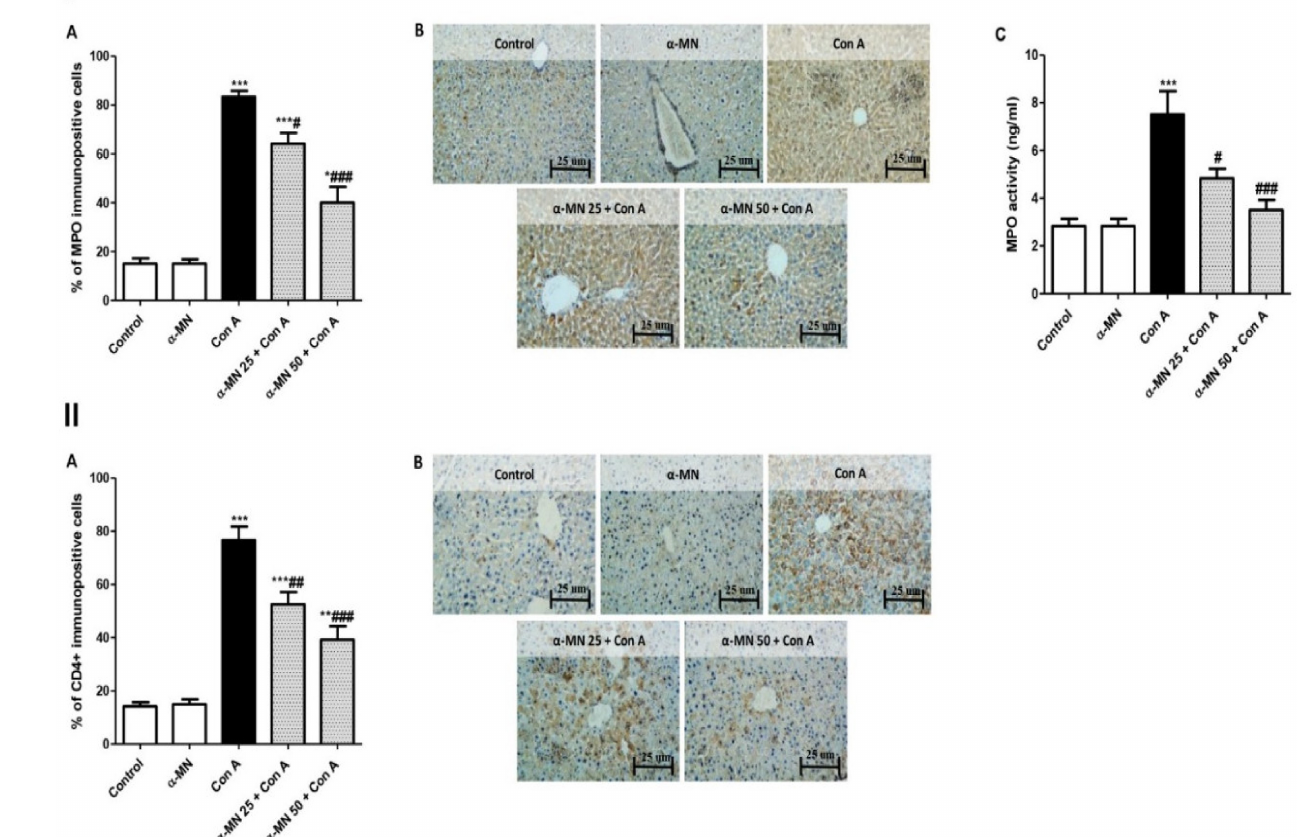
Figure 4. Alpha-mangostin ( α -MN) decreased concanavalin A (Con A)-induced infiltration of the neutrophiles and the CD4+ T cells into the liver. ( I ) MPO immuno-expression and level; ( II ) Immuno- expression of CD4+ in the hepatic specimen. The immuno-staining of MPO and CD4+ of the control and α -MN groups was minimal while that of Con A was high; α -MN pre-treated groups showed a remarkable lowered level of immunostaining for both MPO and CD4+ ( × 200). Data are the mean ± SE. ( n = 8); *** p < 0.001; ** p < 0.01; * p < 0.05 vs. control group; ### p < 0.001; ## p < 0.01, # p < 0.05 vs. Con A group (one-way